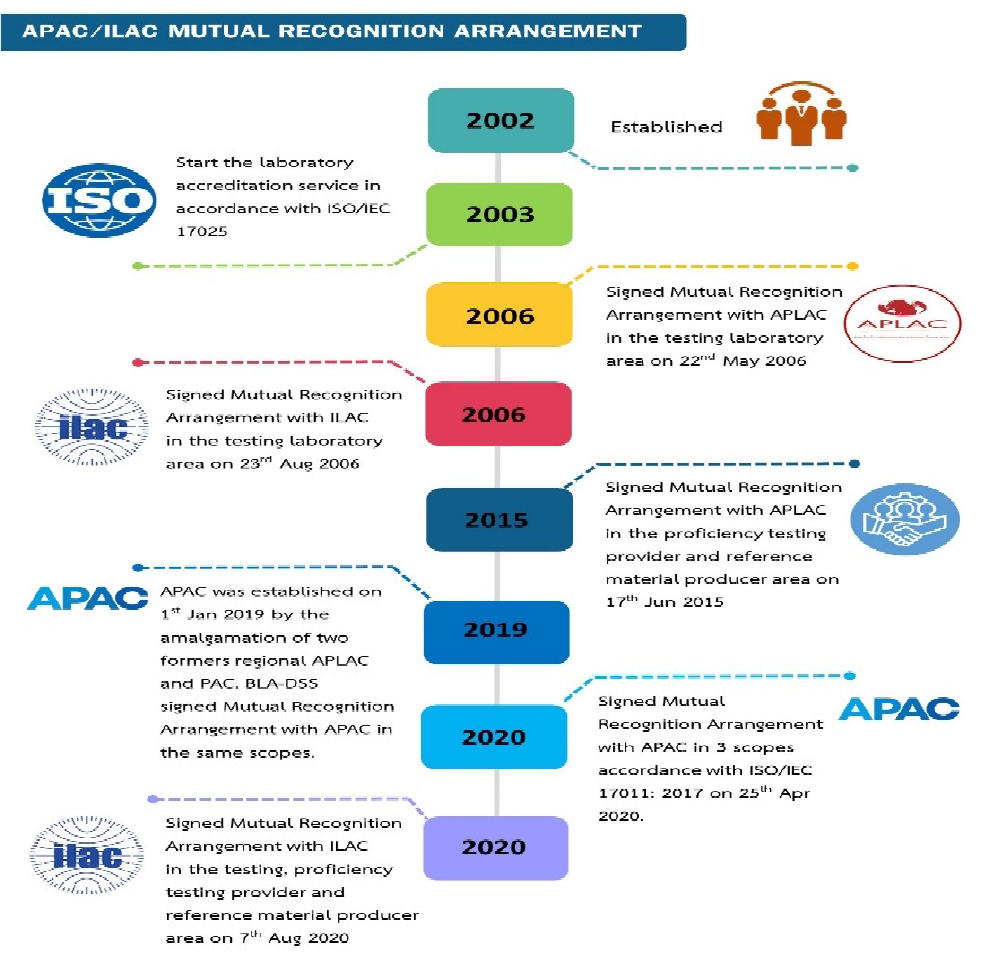
Figure 2. ICQ-MRA Mutual Recognition Agreement Status. Source: MHESI